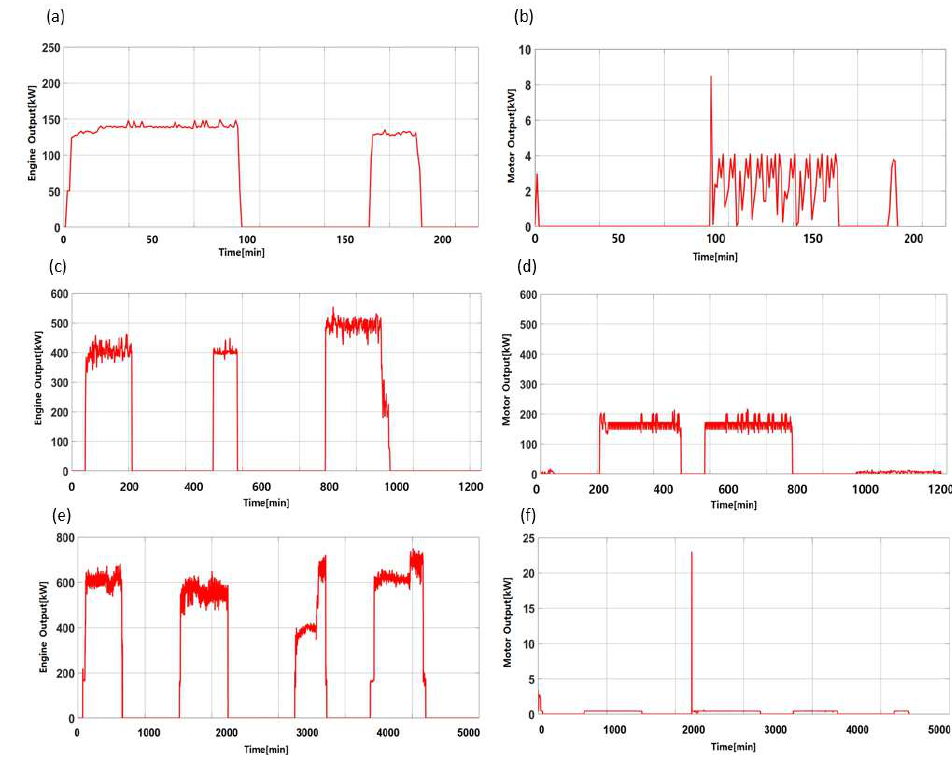
Figure 7. Load profile of battery hybrid system: ( a ) engine load of 4.99 tons, ( b ) motor load of 4.99 tons, ( c ) engine load of 9.77 tons, ( d ) motor load of 9.77 tons, ( e ) engine load of 47 tons, and ( f ) motor load of 47 tons.